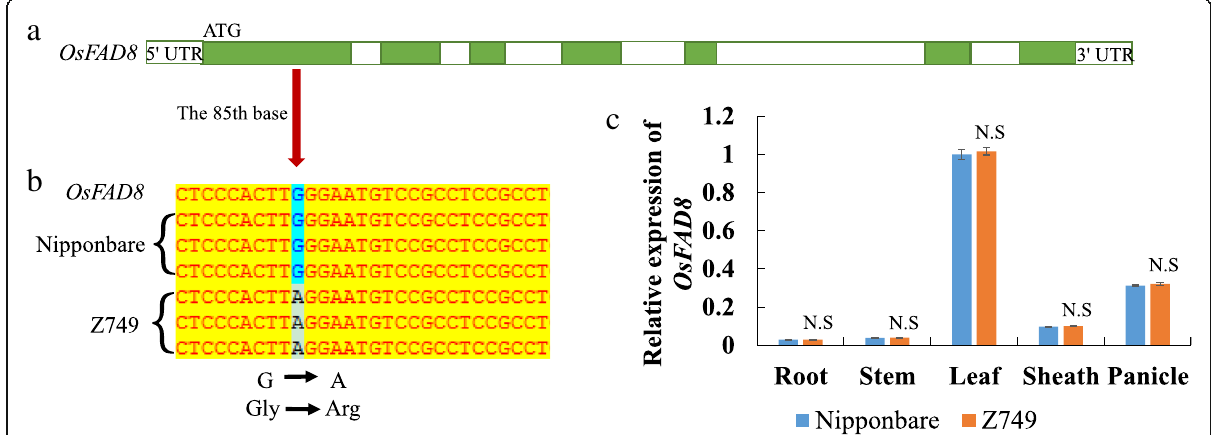
Fig. 3 Blast analysis and expression level of OsFAD8 in Nipponbare and Z749. a Sketch map of OsFAD8 ( Os07g0693800 ), b difference in sequences of OsFAD8 between Nipponbare and Z749. Green boxes indicate exons, white boxes indicate introns and 3 ’ untranslated region; red arrows indicate the alteration of a codon. c The relative expression levels of OsFAD8 in root, stem, leaf, sheath and panicle between Nipponbare and